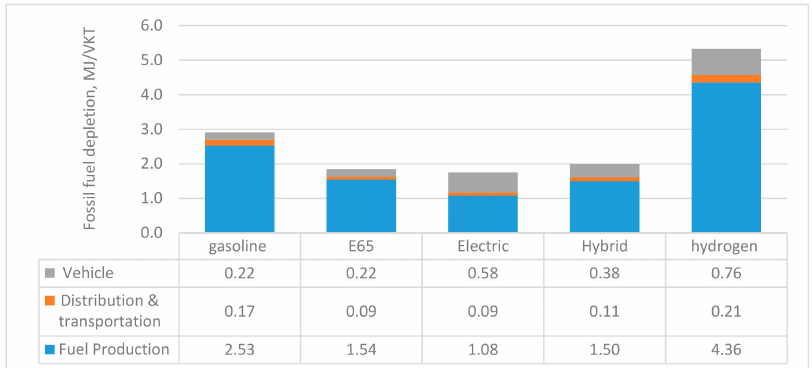
Figure 5. Fossil fuel depletion for di ff erent fuel options (tailpipe emissions are omitted as there were no FFD associated with tailpipe